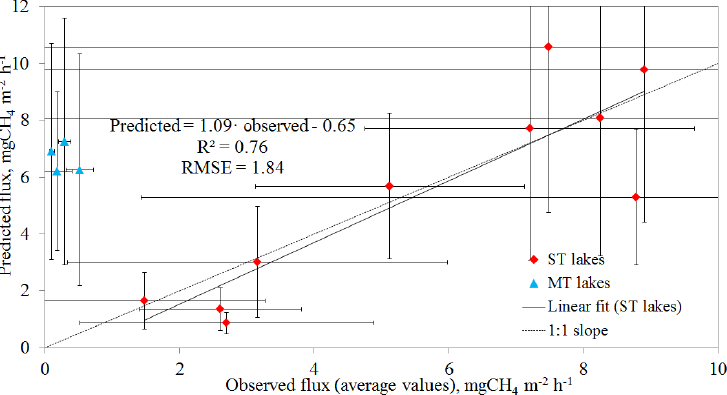
Figure 4. Observed versus predicted values of methane flux. Whiskers denote ± 1SD. Predicted flux uncertainties are calculated from bootstrapping (see Sect. 2.2.3) and are explained by high uncertainty in model parameters adopted from literature (see Appendix A). High magnitudes of observation SDs may be explained by ebullition and SOC behavior of lakes as methane sources (see Sect. 4.3). Note that predicted flux uncertainties are higher than the magnitude of observation SDs for the MT lakes but less for the ST